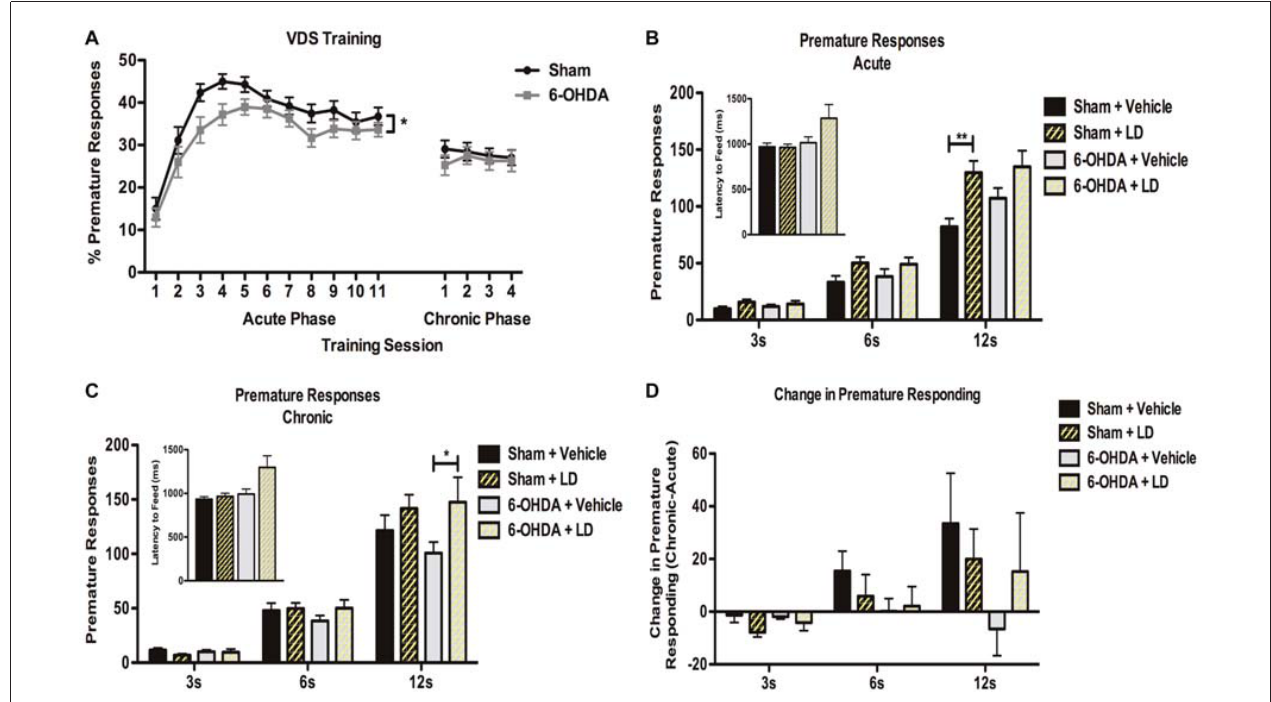
FIGURE 4 | Effect of acute and chronic LD treatments in premature responding in the VDS. (A) Behavior performance in the training phase of the VDS protocol for both 6-OHDA ( n = 28) and sham ( n = 31). (B) Comparison of premature responding between sham and 6-OHDA animals acutely treated with LD (sham + LD, n = 15; 6-OHDA + LD, n = 13), and their respective vehicle controls (sham + vehicle, n = 8; 6-OHDA + vehicle, n = 13) for each type of delay trials. Inset indicates average latency to feed for all groups during test. (C) Effects of chronic LD treatments on premature responding on sham and 6-OHDA treated with LD (sham + LD, n = 15; 6-OHDA + LD, n = 14); and their respective vehicle controls (sham + vehicle, n = 13; 6-OHDA + vehicle, n = 13). Inset indicates average latency to feed for all groups during test. (D) Comparison between premature responding in acute and chronic phases of testing (sham + LD, n = 15; sham + vehicle, n = 8; 6-OHDA + LD, n = 13; 6-OHDA + vehicle, n = 13). Data presented as mean ± SEM. ∗ p < 0.05; ∗∗ p < 0.01. were not significantly affected by lesion ( F ( 1,46 ) =